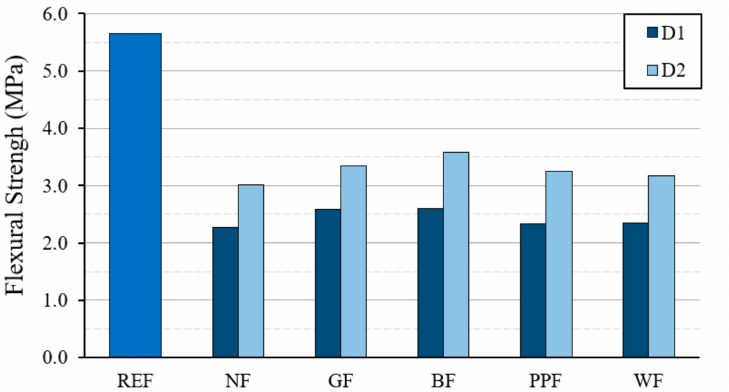
Figure 6. Results of the flexural strength test on standard 4 × 4 × 16 cm 3 specimens.